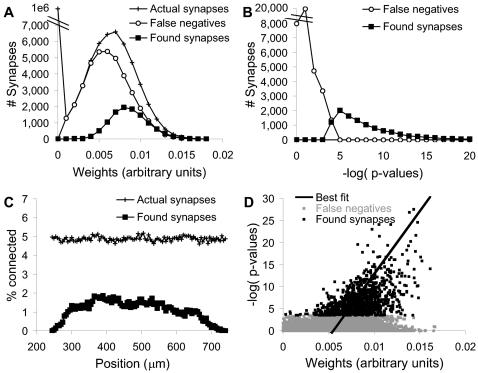
Synapse Classification Results.(A) Distribution of weights of synapses and classified synapses. The false negatives distribution had a peak below that of the found synapses, but it did include many instances of high synaptic weight. (B) Distribution of p-values of classified and rejected synapses. (C) Distribution of actual and found synapses as a function of position on dendrite. Fewer synapses were found proximal and distal to the soma. (D) Scatter plot of p-values vs. actual synaptic weights, for 20% noise, 20% neural variability and 80 repeats. Best straight-line fit for x-variance is shown.